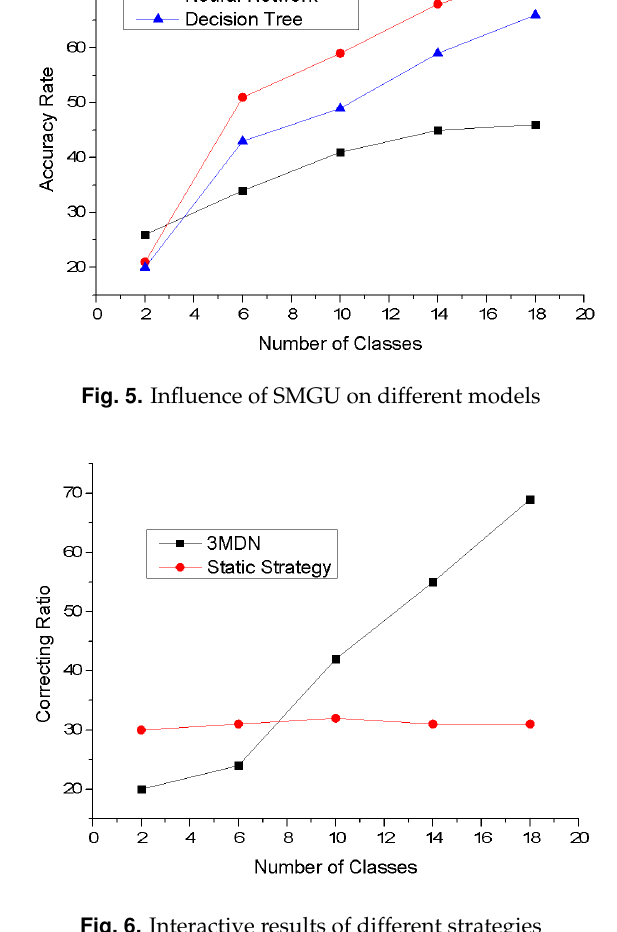
Fig. 6. Interactive results of different